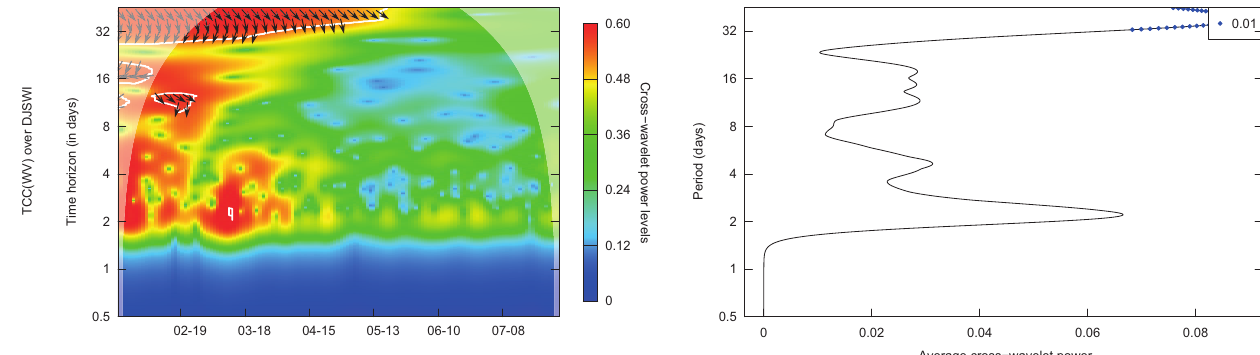
Figure 5. Wavelet coherence: DJSWI returns vs. increase in worldwide COVID-19 cases. Average cross-wavelet power. Source: Own